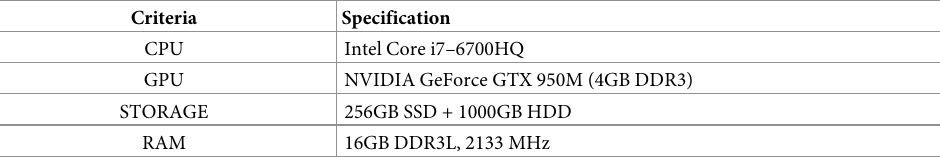
Table 4. Hardware specifications for the machine used during about